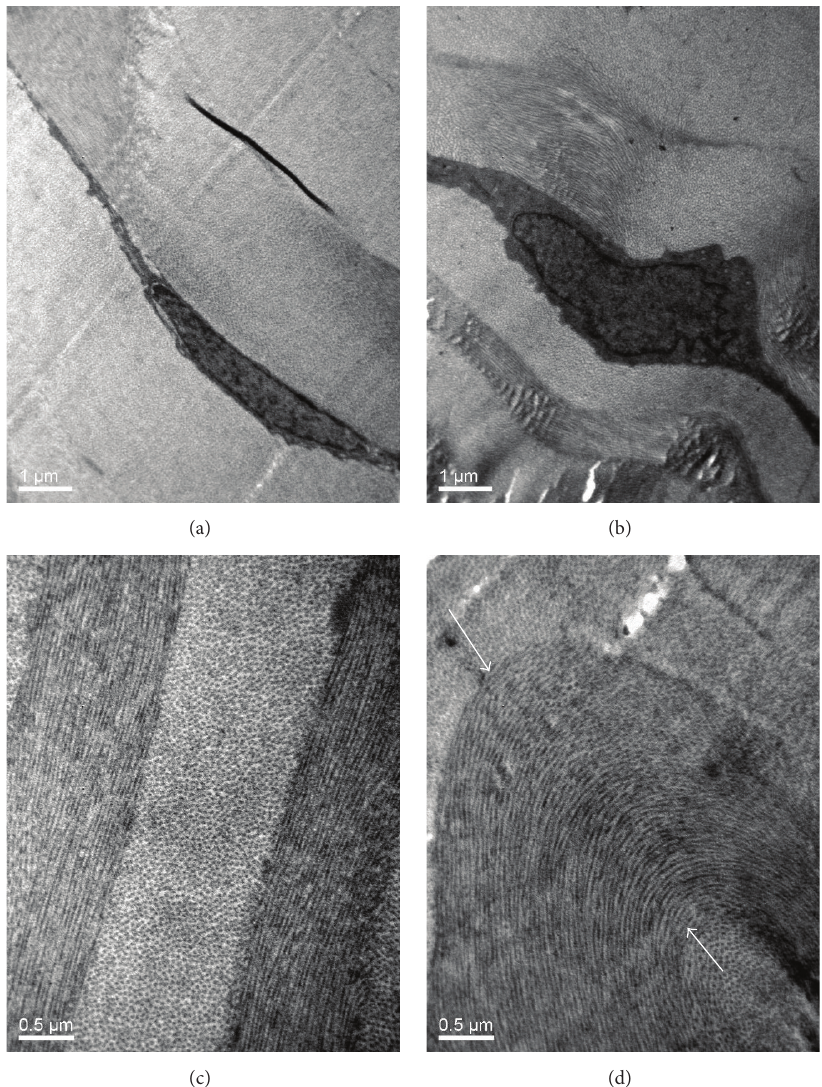
Figure 4: (a, c) Blank control group. (b) TEM of HIFU-treated zones demonstrated that the morphologic appearance of the keratocytes was close to normal. (d) The typical structures of stromal collagen shrinkage (white arrows) are within the HIFU treatment